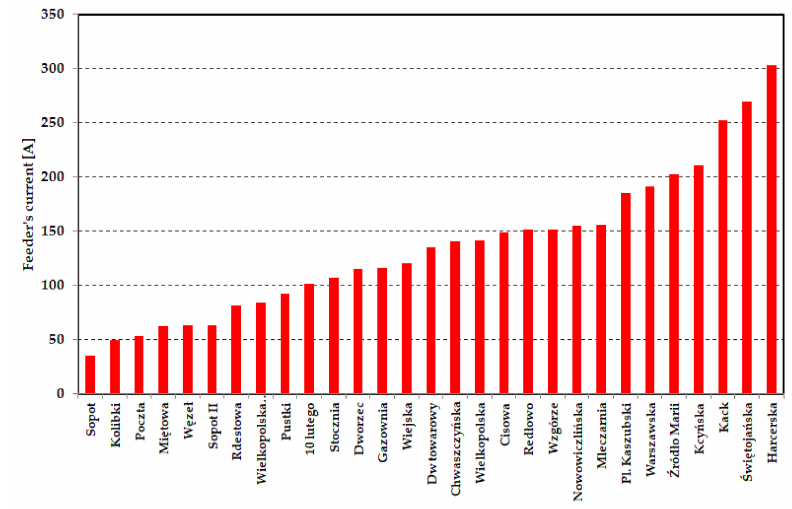
Figure 7. Results of computation of average load current of particular supply sections (assumed power of the charging station: 44 kW).